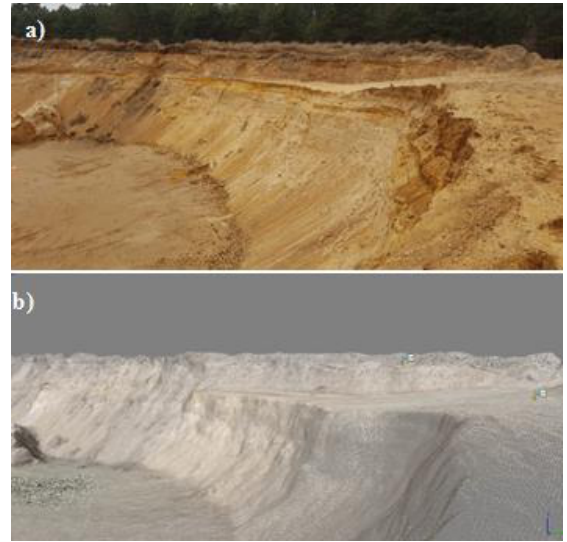
Figure 13. Mapping the discontinuity lines through a point cloud. ( a ) Photo of the area under analysis ( b ) Cloud of points in the analysed area.